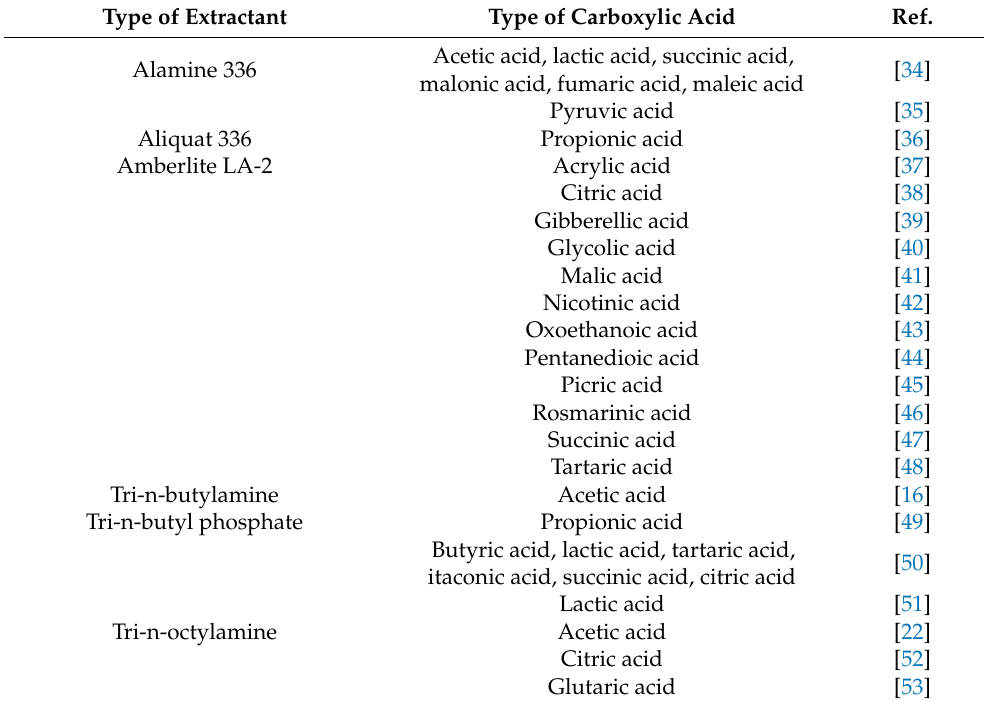
Table 1. A brief review of the reactive extraction using various